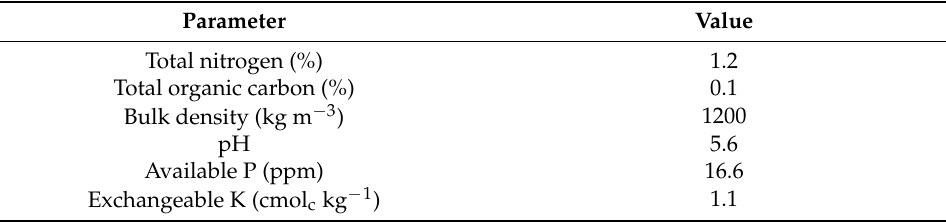
Table 1. Soil parameters for a composite topsoil (0–20 cm) sample collected from the experimental plots before the start of the experiment in